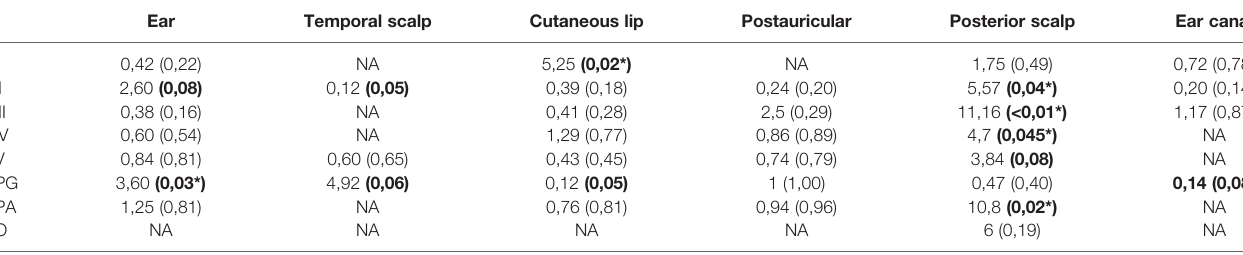
TABLE 3 | Odds ratio of lymph node metastases per location ( > 5 patients) per level ipsilateral. Ear Temporal scalp Cutaneous lip Postauricular Posterior scalp Ear